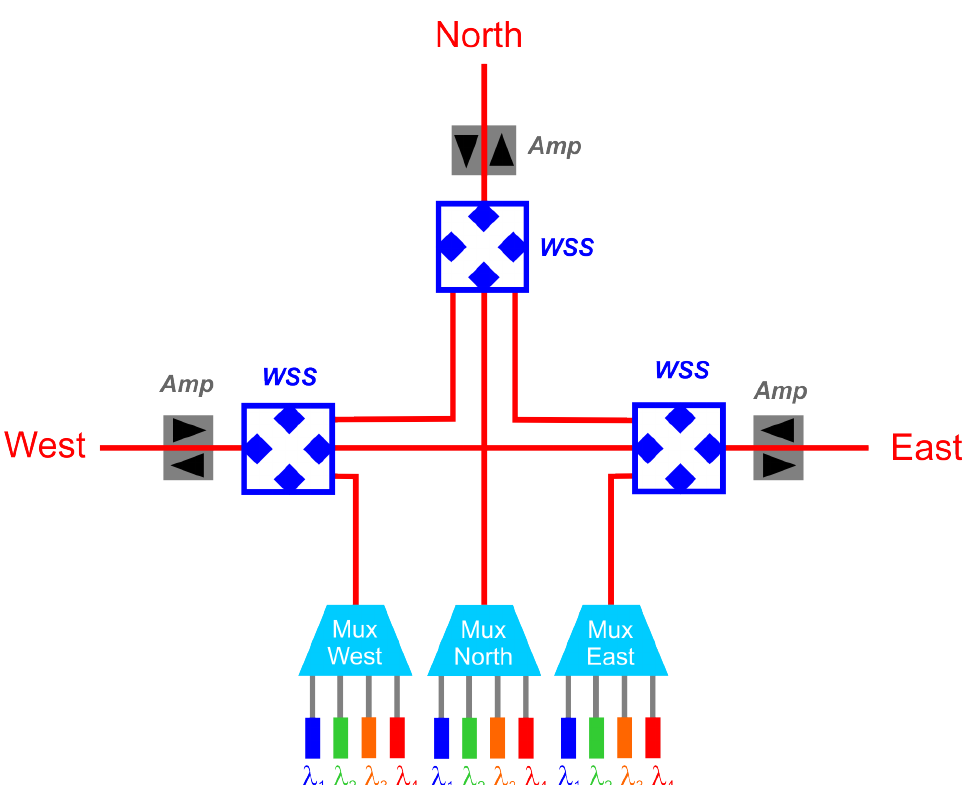
Figure 1. Schematic diagram of conventional